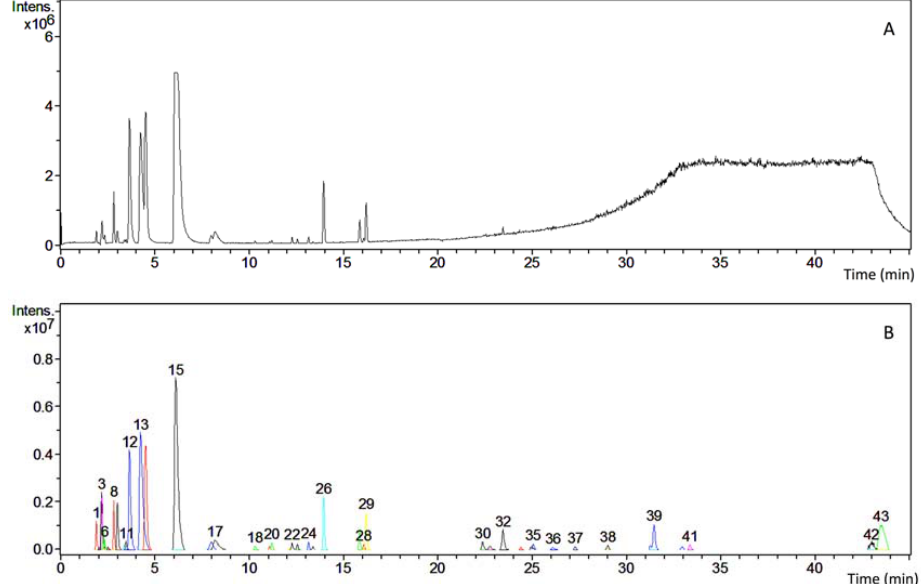
Figure 2. The LM extract consists of a complex mixture of phytochemicals. An HPLC chromatogram with ( A ) total ion chromatogram TIC and ( B ) processed chromatogram showing the presence of at least 43 different peaks each corresponding to a compound with a discrete molecular weight. From the retention time and protonated molecular ions [M + H] + from the MS spectra, some peaks corresponding to QA were tentatively assigned: Peak 12 and 14 Hydroxylupanine/Nuttalline/Oxylupanine MW 264; Peak 13 Sparteine MW 234; Peak 15 and 17 Lupanine/ α‐ Lupanine MW 248.